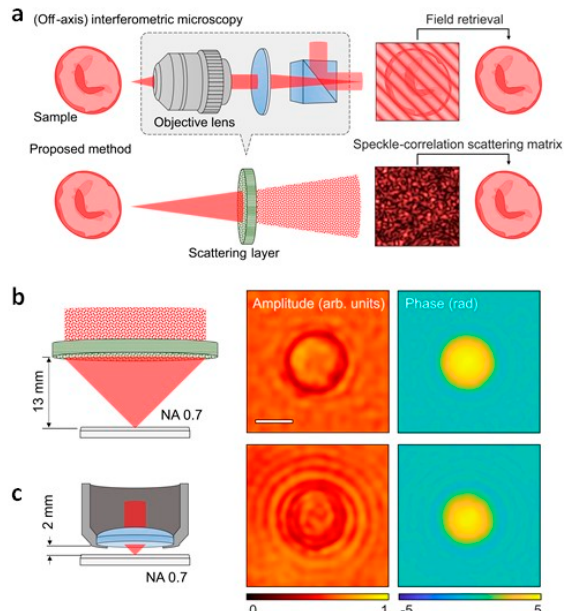
Figure 5. High-resolution long-working-distance holographic microscopy. ( a ) Schematic representation of holographic microscopy system based on conventional off-axis interferometry (top) and SSM (bottom). ( b , c ) The complex amplitude image of a 5 µ m polystyrene bead measured using SSM-based microscopy ( b ) and a conventional method with a long-working distance objective lens ( c ). Adapted with permission from [51], APS. NA, numerical aperture.